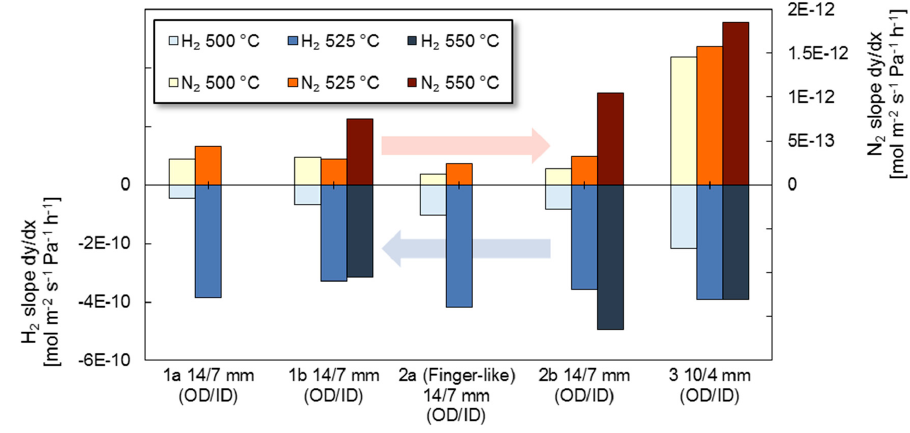
Figure 6. Slope of hydrogen and nitrogen permeance over time.